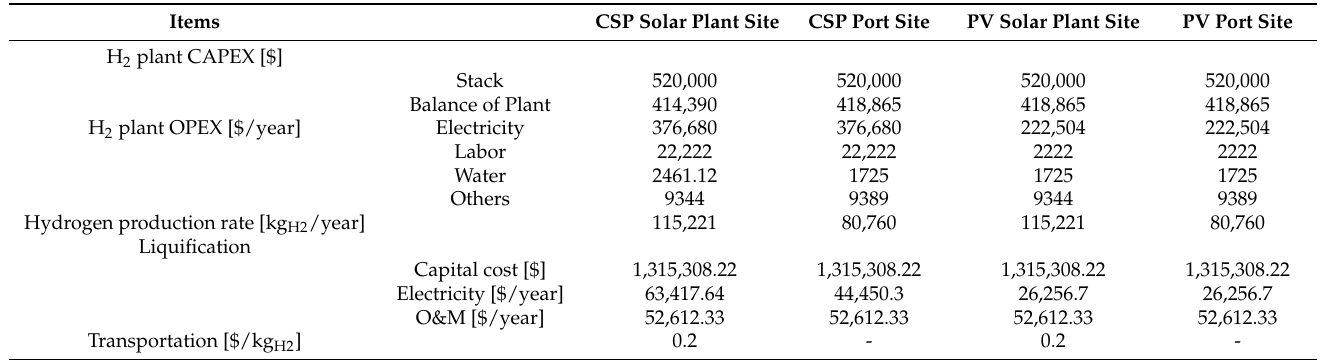
Table 8. Hydrogen plants and production metrics along with liquification and transportation costs in each scenario.